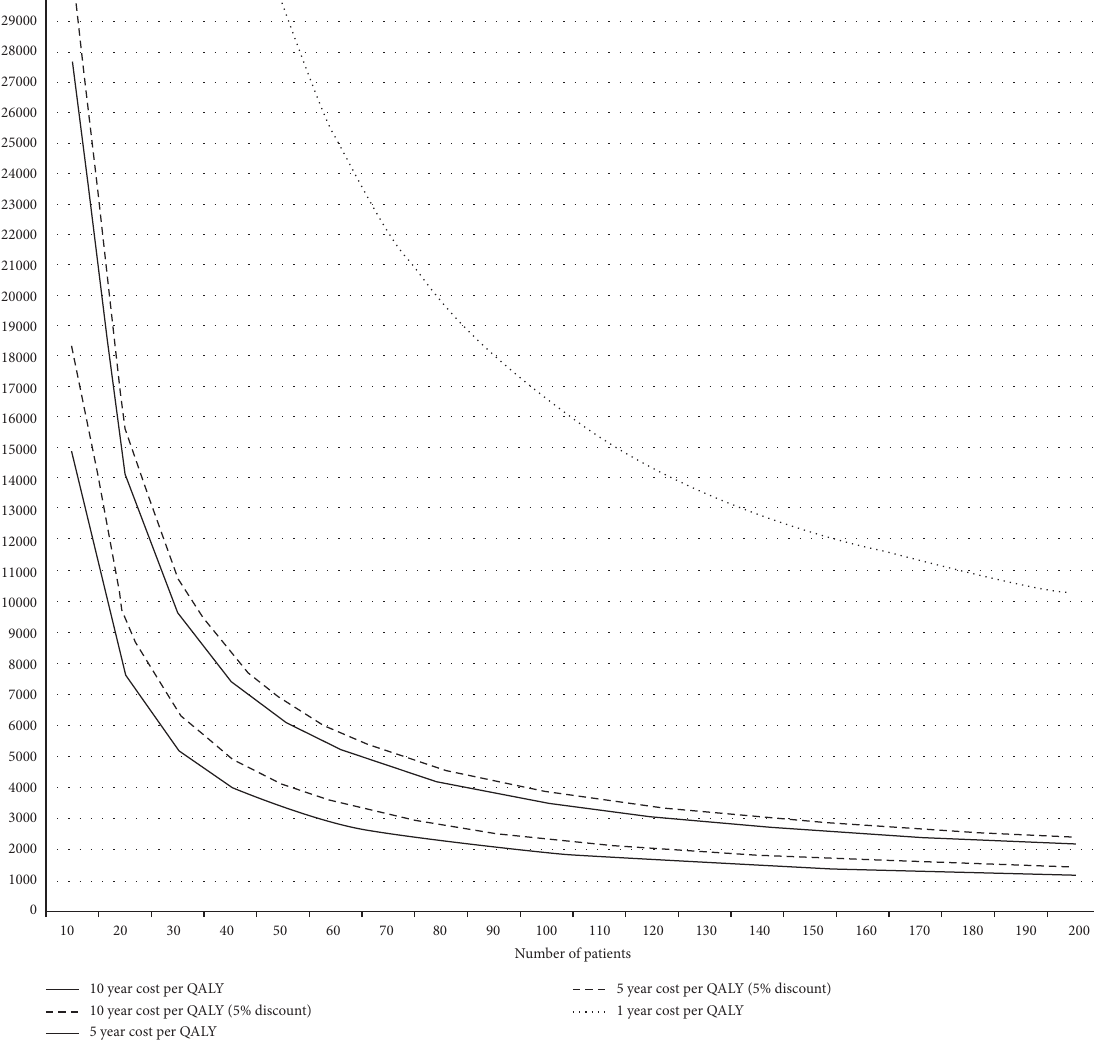
Figure 1: Cost per QALY for robotic relative to manual total hip arthroplasty according to annual unit volume and the time point used to define QALYs gained following